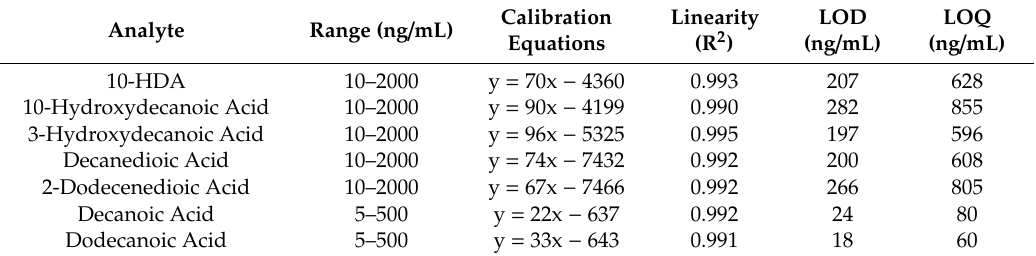
Table 2. Calibration curve data as well as limits of detection (LOD) and quantification (LOQ). Calibration Analyte Range (ng / mL) Equations